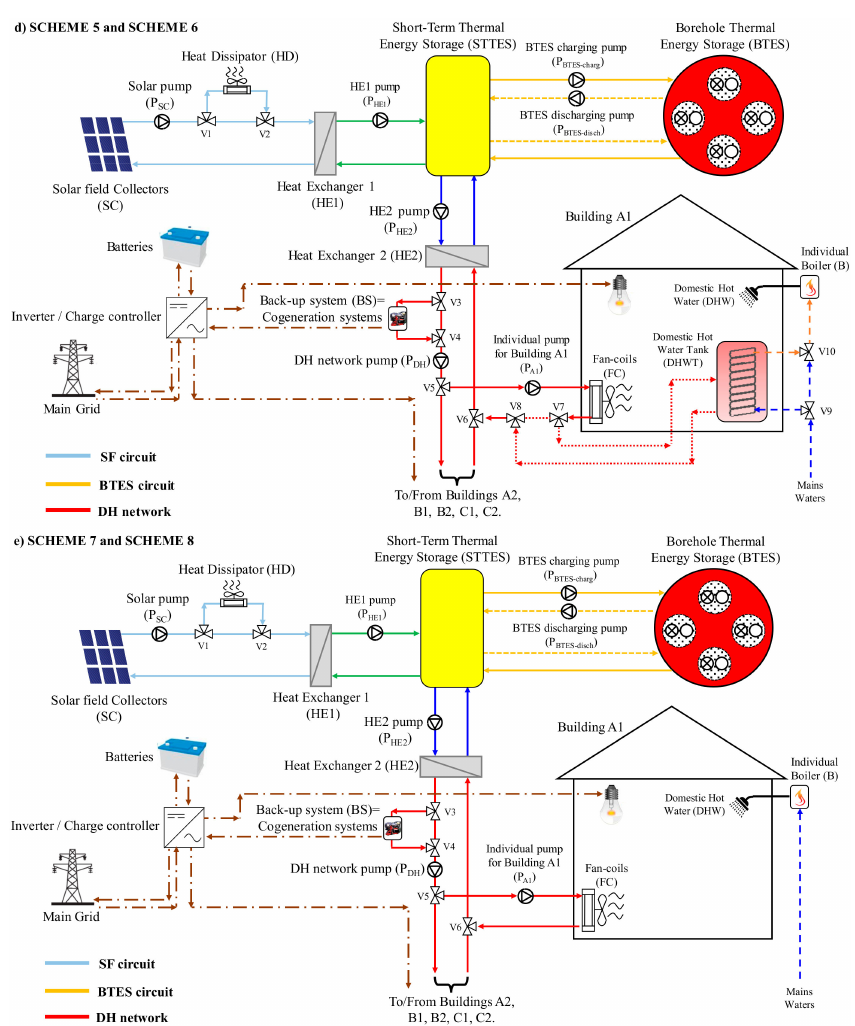
Figure 2. Proposed CSHPSS configurations: schematic of the SCHEME 1 ( a ), schematic of the SCHEME 2 and the SCHEME 3 ( b ), schematic of the SCHEME 4 ( c ), schematic of the SCHEME 5 and the SCHEME 6 ( d ), schematic of the SCHEME 7 and the SCHEME 8 ( e